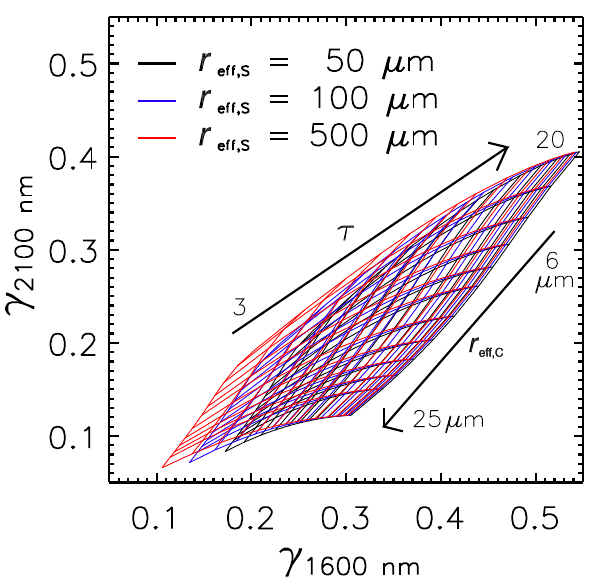
Figure 2. Bispectral retrieval grids of cloud top nadir reflectiv- ity γ 1600nm and γ 2100nm assuming three different effective snow grain sizes r eff , S of 50, 100, and 500µm. The simulated reflectiv- ities cover cloud optical thickness τ between 3 and 20 and cloud droplet effective radius r eff , C between 6 and